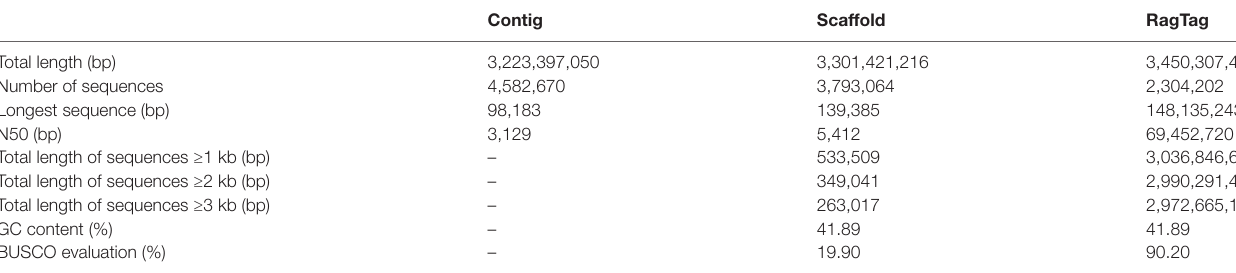
TABLE 3 | Genome assembly statistics in our study.